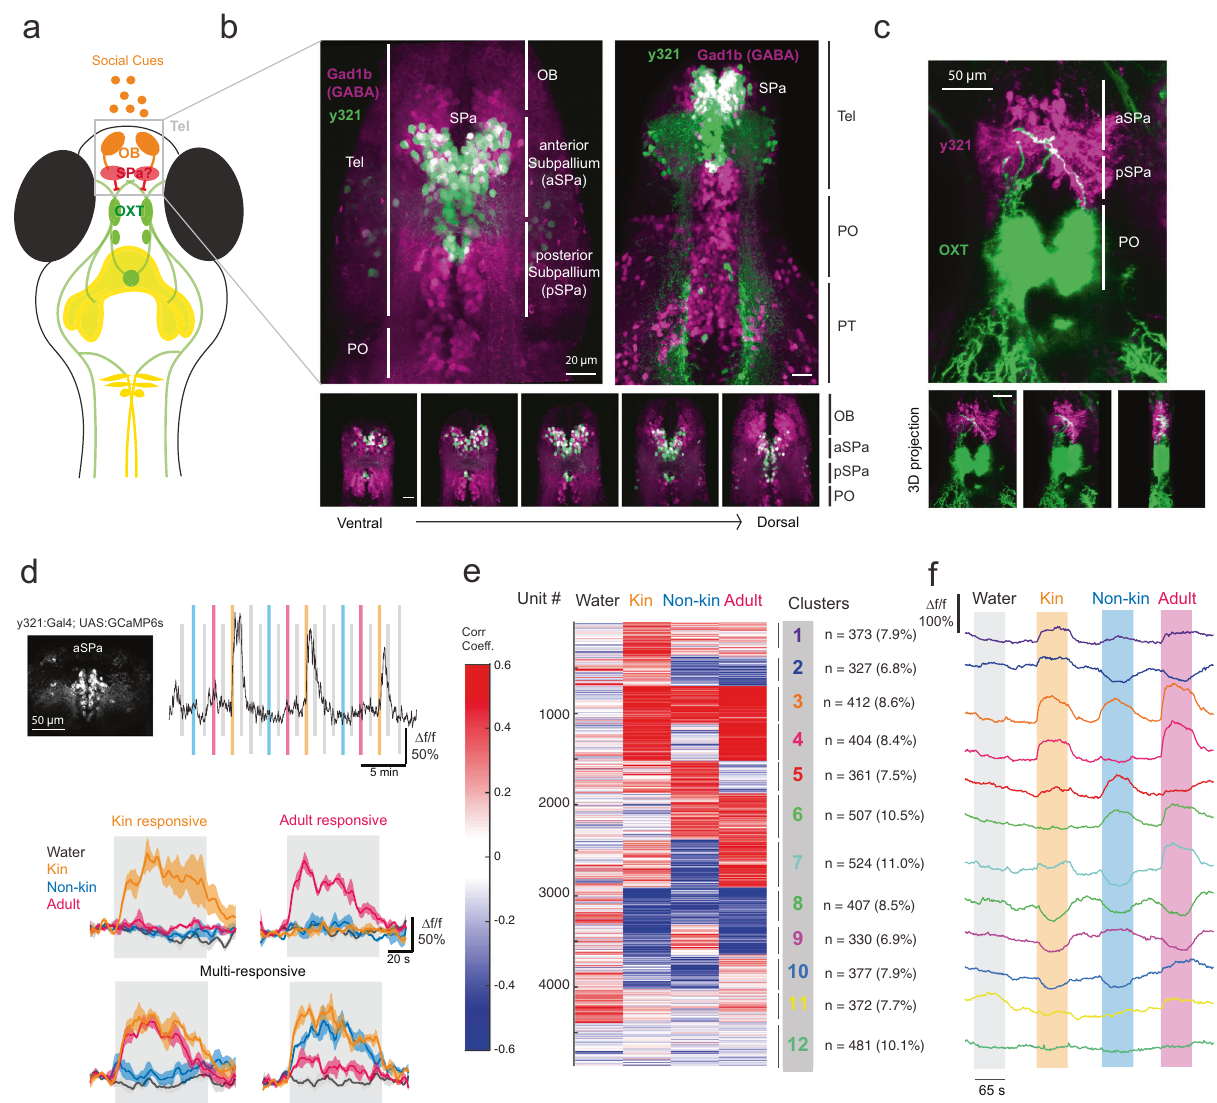
Fig. 4 A genetically de fi ned GABAergic subpallial population discriminates social cues. a Schematic depicting the hypothesized telencephalic subpallial (SPa) pathway linking olfactory bulb conspeci fi c cue responses to preoptic OXT neurons. b Top left: Maximum-projection image showing overlap of Tg(y321:Gal4;UAS:Kaede) (green) with GABAergic neurons labeled by Tg(Gad1b:RFP) (magenta) in the telencephalon. y321 and Gad1b co-expression occurs in both the anterior subpallium (aSPa, rostral to the anterior commissure) and posterior commissure (pSPa, caudal to the anterior commissure and rostral to the preoptic area). Top right: Lower-magni fi cation maximum-projection image showing overlap of Tg(y321:Gal4;UAS:Kaede) with Tg(Gad1b:RFP) (magenta). Overall, 88.2 ± 1.5% of aSPa y321 and 87.3 ± 3.06% of pSPa y321 neurons are GABAergic ( n = 7 fi sh). OB olfactory bulb, Tel telencephalon, PO preoptic area; PT posterior tuberculum. Bottom: y321 and Gad1b overlap shown across different z-planes. All scale bars = 20 µ m. This experiment was repeated on 7 fi sh with similar results. c OXT neuron dendrites project into the location where SPa y321 neurons reside. Top: Maximum-projection image; Bottom: 3D projection at different rotation angles. Scale bar = 50 µ m. This experiment was repeated on more than 3 fi sh with similar results. d 2-P calcium imaging was performed on Tg(y321:Gal4; UASGCaMP6s) neurons in the aSPa region on fi sh exposed to kin, non-kin, and adult water cues. See Supplementary Figs. 4, 5 for imaging and analysis of the same telencephalic regions in Tg(HuC:GCaMP6s; Gad1b:RFP fi sh) . Top left: Maximum-projection image showing the aSPa y321 region imaged. Scale bar = 50 µ m. Top right: Example Δ f/f trace of a kin-responsive unit. Bottom: Stimulus-triggered averages for units that are kin-selective, adult-selective, or responsive to multiple conspeci fi c cues. Shaded region indicates SEM. This experiment was repeated on 4 fi sh with similar results. e K-means clustering (k = 12) was performed on the matrix of correlation coef fi cients (color coded blue to red) to water and conspeci fi c stimuli n = 4875 units from 4 fi sh. Number of units within each cluster and percentage representation of total units are displayed on the right. Clusters speci fi c to kin, non-kin, and adult water, as well as clusters with mixed selectivity were observed. f Mean stimulus-triggered Δ f/f for each cluster, aligned to stimulus onset. Order of clusters is the same as in ( e ). Source data are provided as a Source Data fi water-borne social cues derived from closely related conspeci fi cs, water (Supplementary Fig. 7). Similarly, in 8 – 10-dpf tethered fi sh, we posited that these cues might reduce the nocifensive behavior kin water signi fi cantly reduced the frequency of large-angle swims induced by the stimulation of TRPA1 receptors. Indeed, increased in tethered fi sh after kin cue delivery and TRPA1 stimulation but swim speed triggered by nociceptive TRPA1 receptor activation not during other epochs (Fig. 6a, Supplementary Fig. 8a). Cor- was signi fi cantly ameliorated by the presence of kin-conditioned respondingly, the average calcium responses of individual OXT PO